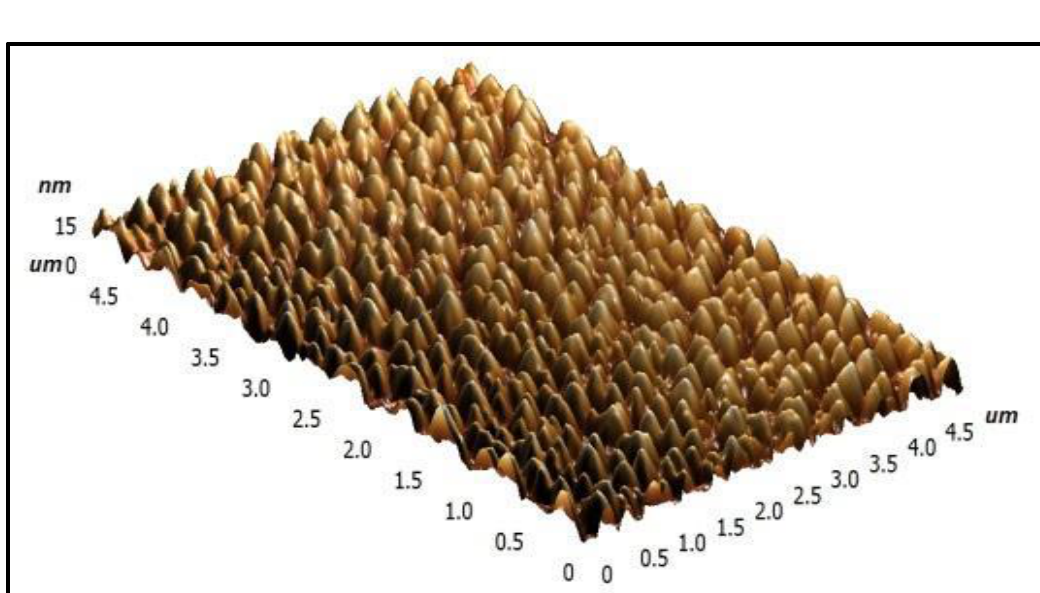
Figure 13. AFM of